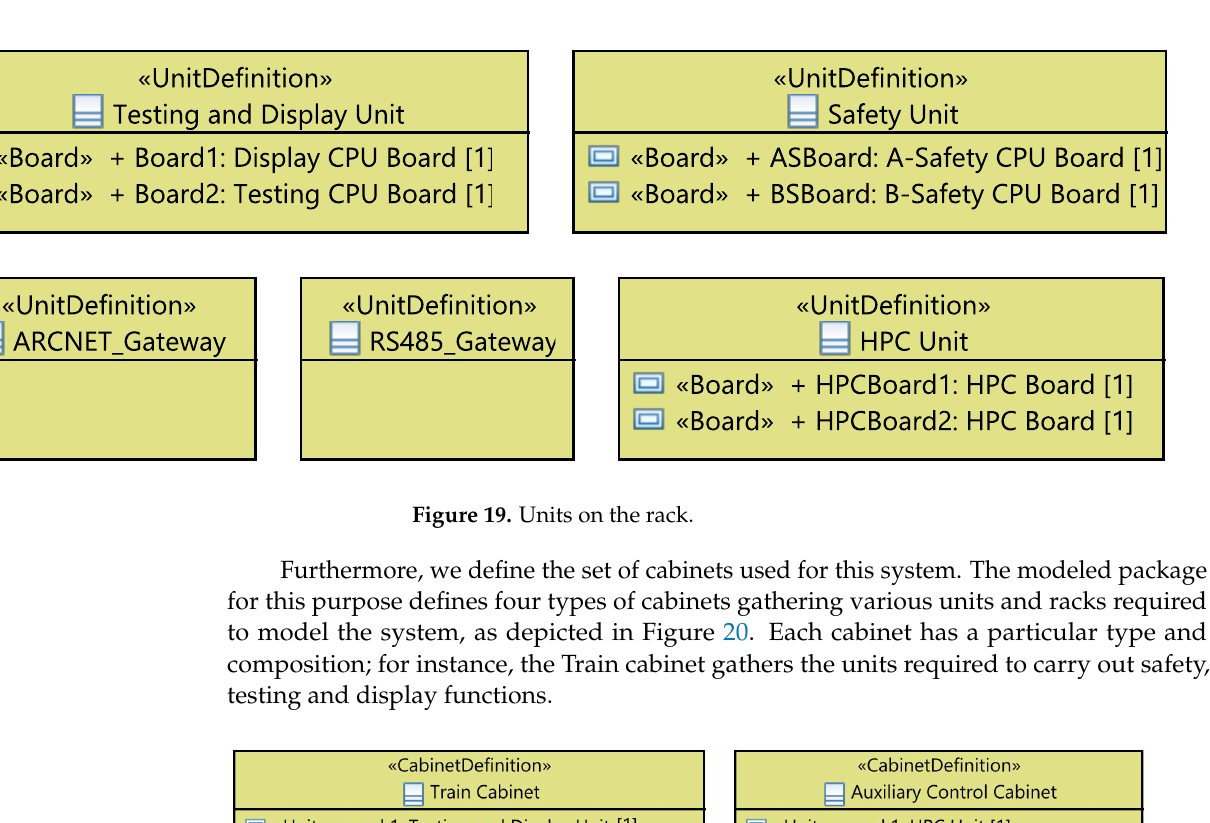
Figure 18. Electronic boards on the rack.